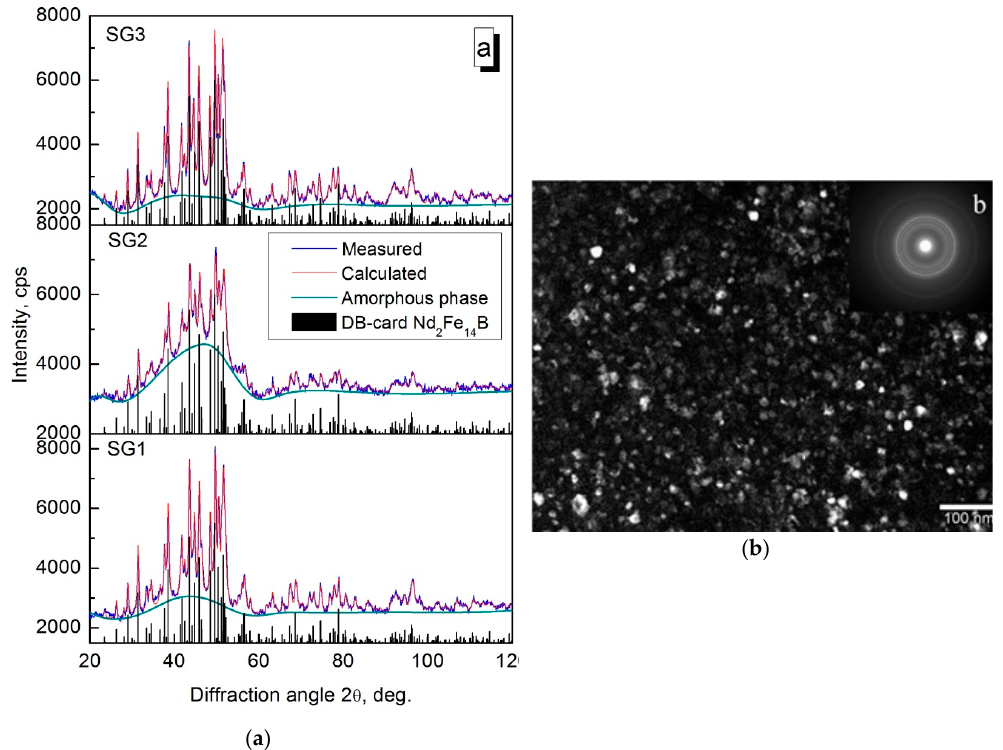
Figure 1. X-ray diffraction (XRD) patterns of melt spun samples ( a ) and dark-field TEM image of the SG1 sample after quenching ( b ).